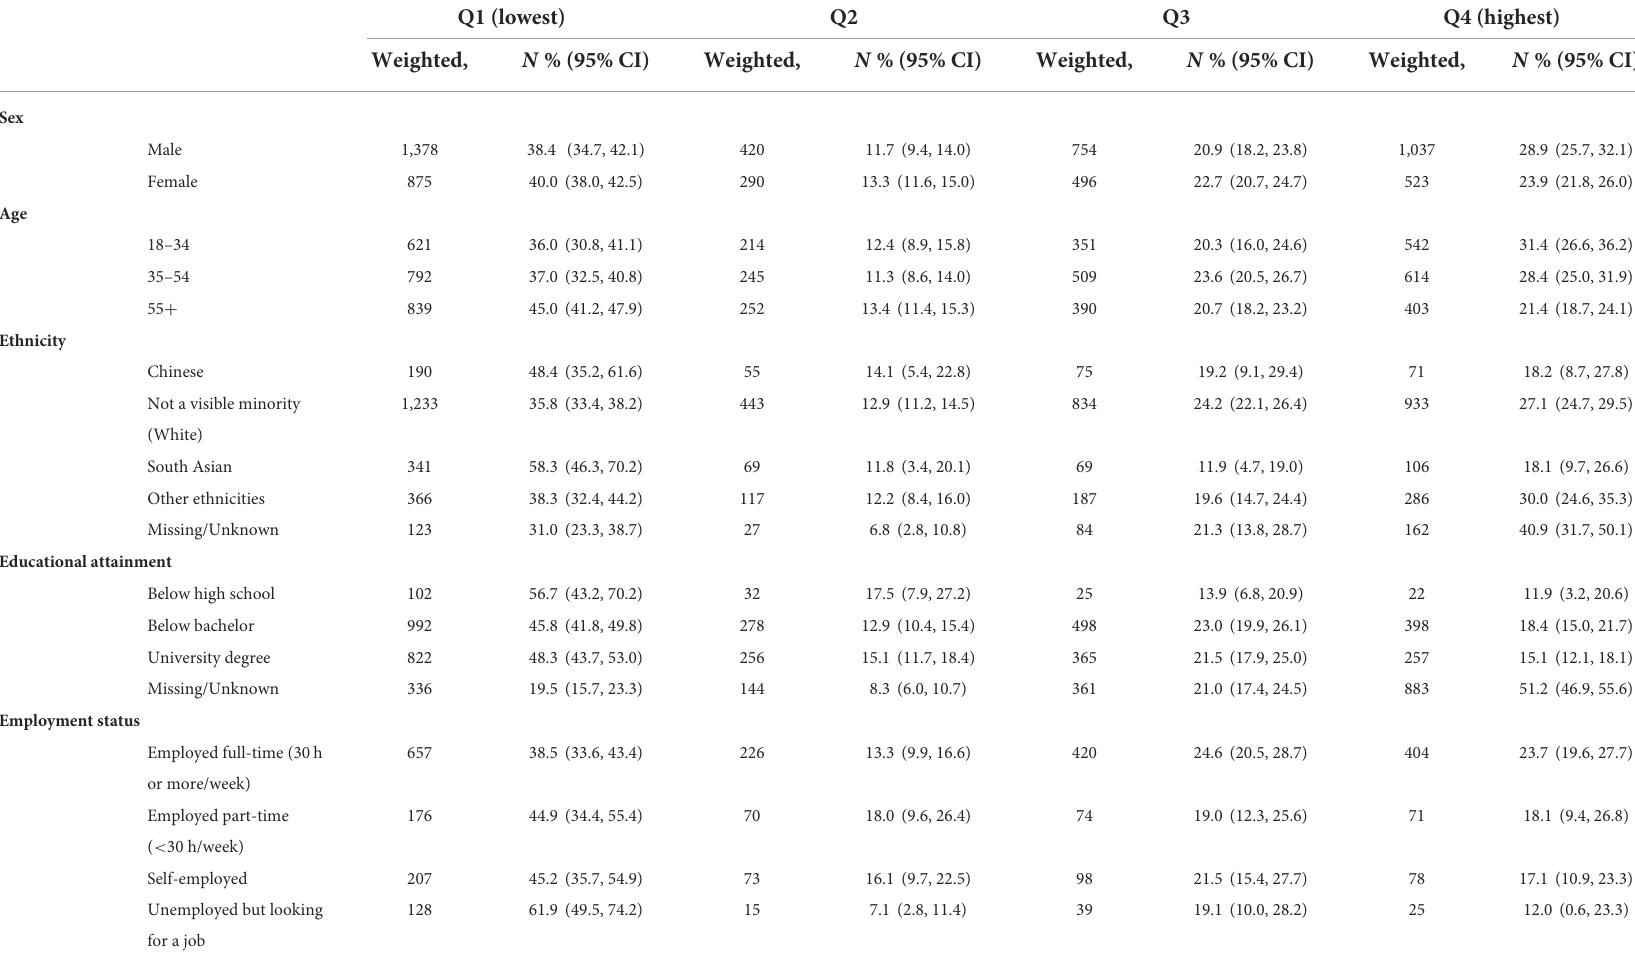
TABLE 2 Characteristics of study participants by interpersonal contact (unweighted, N = 4,515), March 8, 2021- December 6,